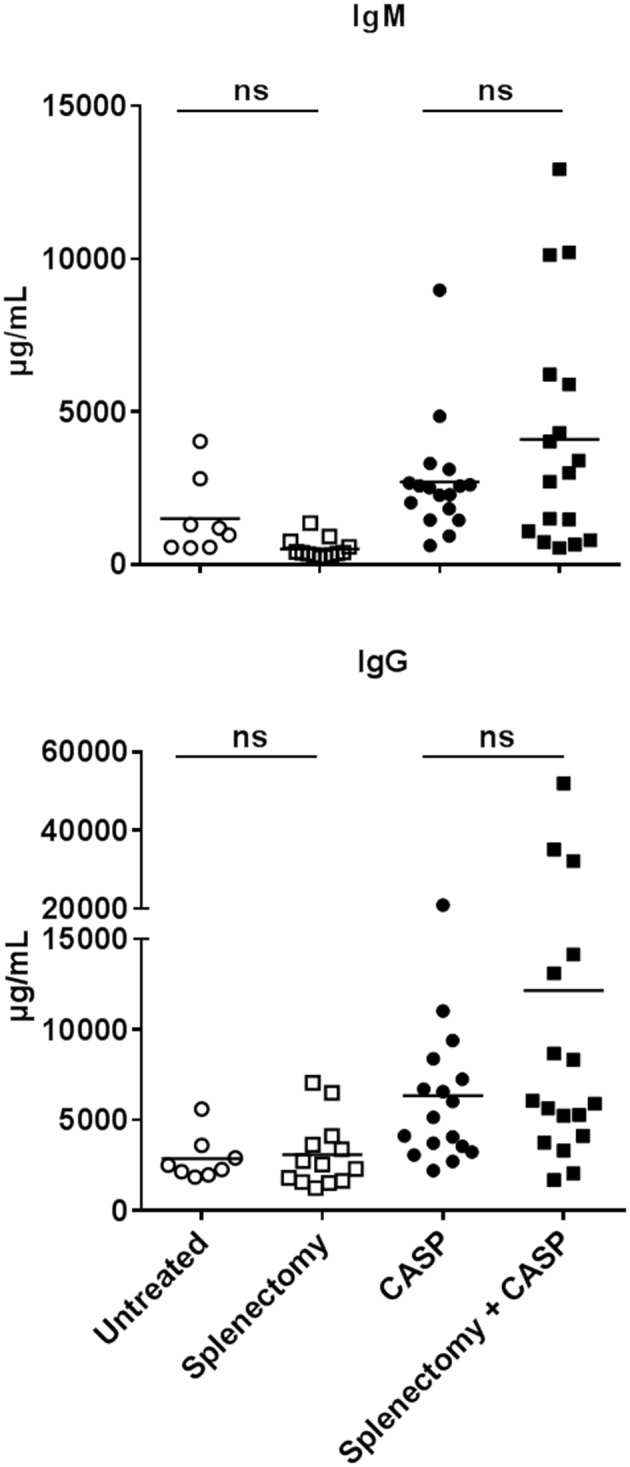
Serum IgM and IgG concentration 14 days after sepsis and splenectomy. Female C57BL/6 mice were CASP-operated and their spleen was explanted in parallel. Untreated, splenectomized-only and CASP-only animals served as controls. 14 days later animals were anesthetized and blood was collected. IgM and IgG serum concentrations were measured by Luminex®-technology. Shown is the mean of the collective data from two independent experiments with a similar tendency. We used the One Way ANOVA and Bonferroni post-hoc test for selected pairs for statistical evaluation. *p < 0.05; N = 8–17 per group.